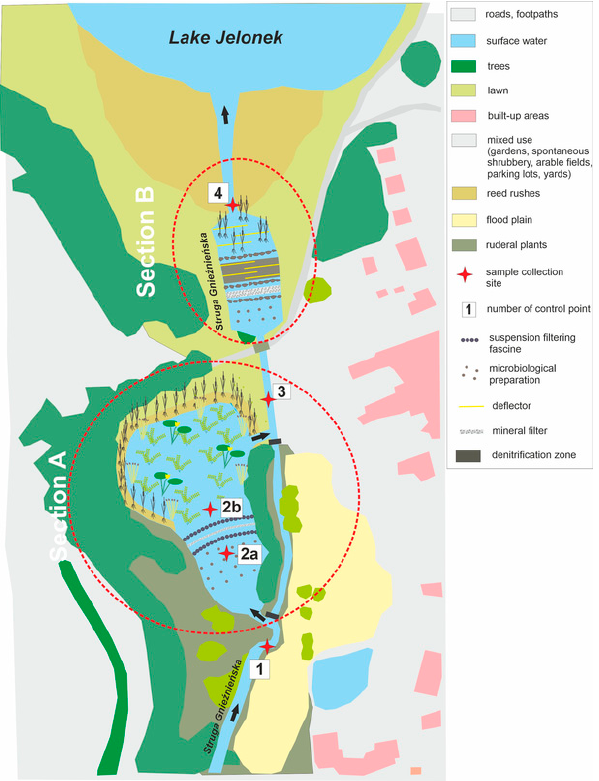
Figure 5. Location of sections and individual elements of the SED-BIO system and monitoring points.